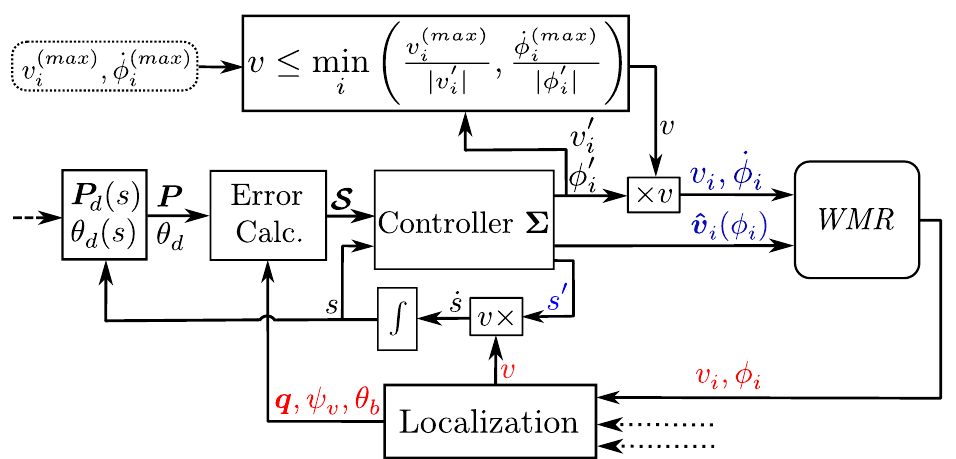
Figure 3. Schematic block diagram of the whole